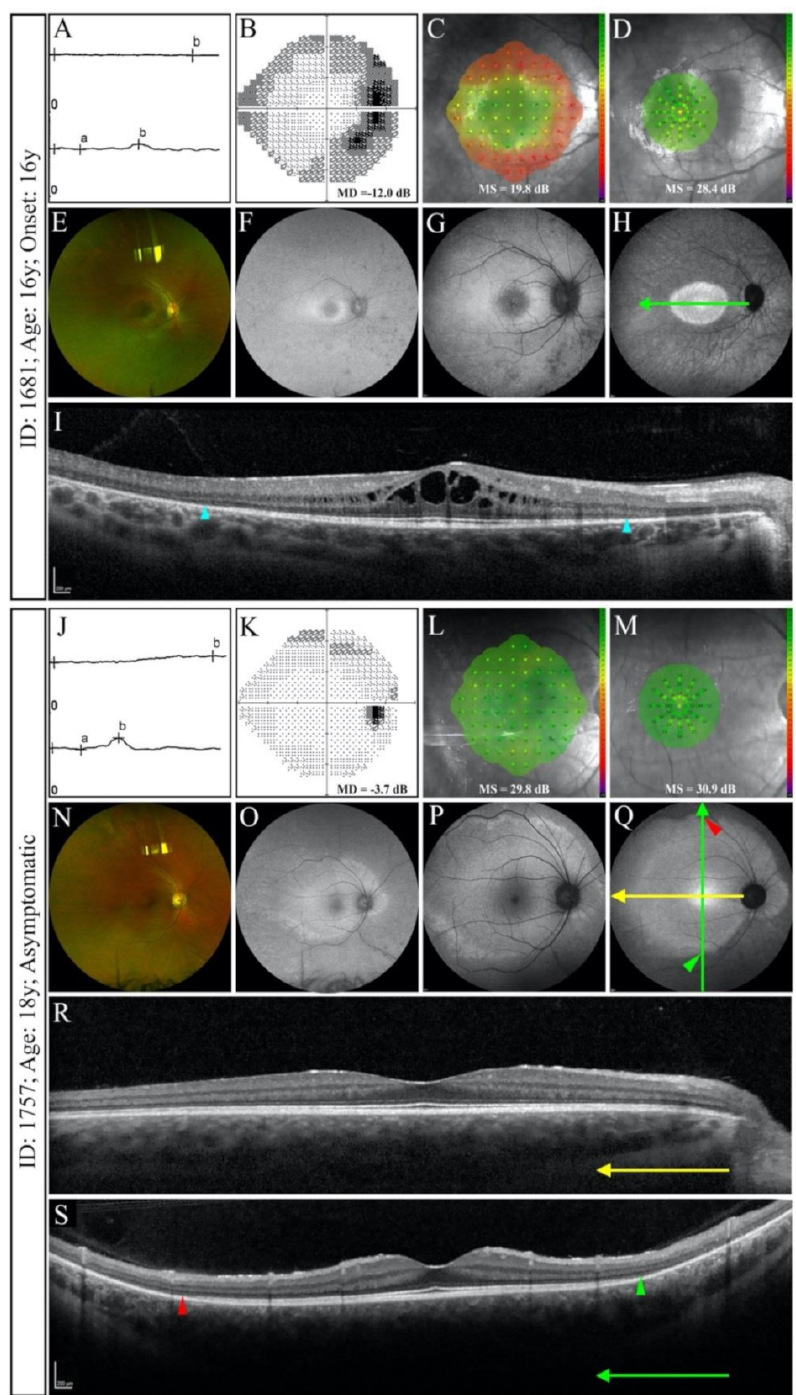
Figure 3. Functional and structural findings in two siblings with c.772_773delins16. The younger sibling presented with profoundly reduced rod response and minimal cone response in full-field electroretinography (ffERG; ( A )), constricted visual field in 24-2 Humphrey test ( B ), reduced macular sensitivity in 10-2 MAIA ( C ) and normal foveal sensitivity in 37R MAIA ( D ). Bone spicule pigmen- tation with greater density at nasal side was noted on ultra widefield (UWF) colour photograph ( E ) and a typical macular hyperautofluorescence ring (HAR) was observed on UWF autofluorescence (AF; ( F )), short-wavelength AF (SWAF; ( G )) and near-infrared AF (NIAF; ( H )). However, the borders of HAR could be delineated only on NIAF ( H ). Spectral-domain optical coherence tomography (SD-OCT) showed shortening of the ellipsoid zone (EZ; ( I )). The asymptomatic older sibling